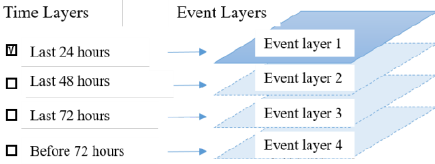
Figure 4 Correspondence between vertical time layers and event display layers